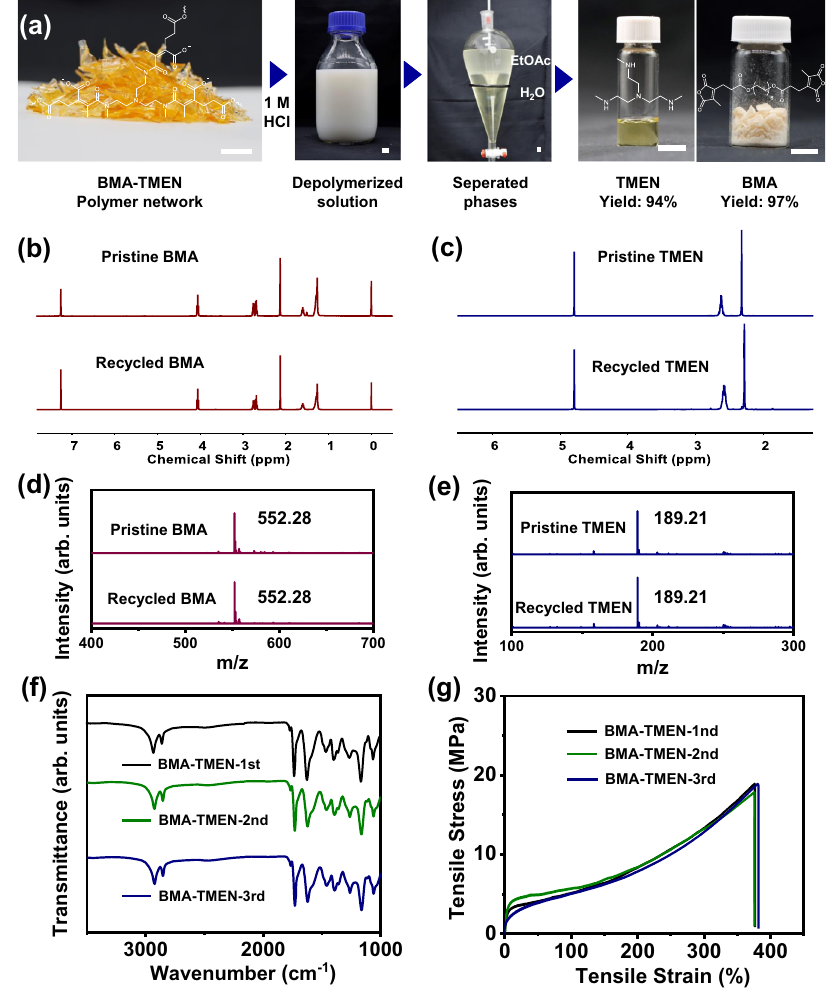
Fig. 4 | Chemical recycling and repolymerization of BMA-TMEN. a Photographs of the depolymerization of polymer networks, the separation and recycling pro- ceduresofBMAandTMENmonomersbytheliquid-liquidextractionmethod(scale bar: 1cm). b 1 H NMR spectra of pristine and recycled BMA. c 1 H NMR spectra of